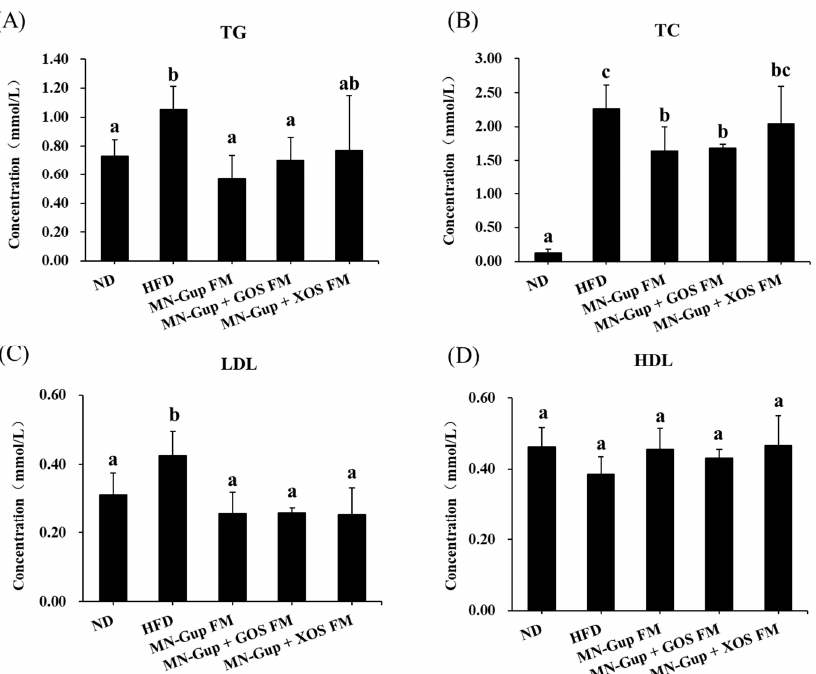
Figure 2. Effects of fermented milk containing MN-Gup or MN-Gup-based synbiotics on lipid profile levels in HFD-induced obese rats. The concentrations of ( A ) triglyceride (TG), ( B ) total cholesterol (TC), ( C ) low-density lipoprotein (LDL) cholesterol, and ( D ) high-density lipoprotein (HDL) cholesterol were measured in rat serum. Different lowercase letters (e.g., a, b, c) indicate significant differences, p < 0.05, ( n = 5). Nutrients 2022 , 14 , 2631